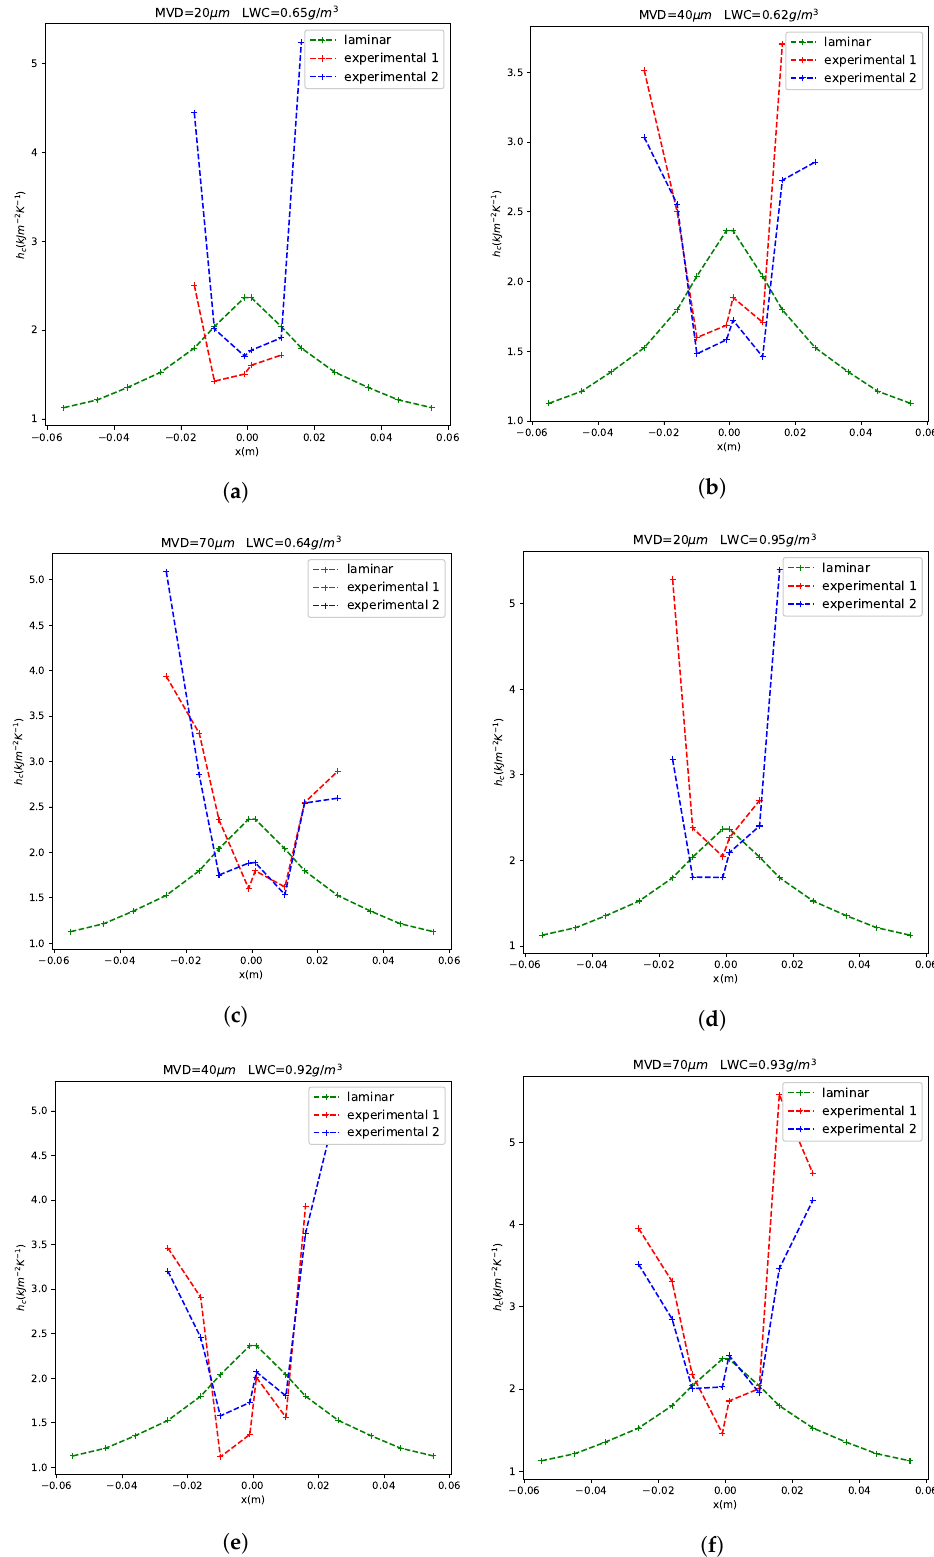
Figure 12. Convective heat transfer coefficient. Test cases: ( a ) 13 ( b ) 14 ( c ) 15 ( d ) 16 ( e ) 17 ( f )